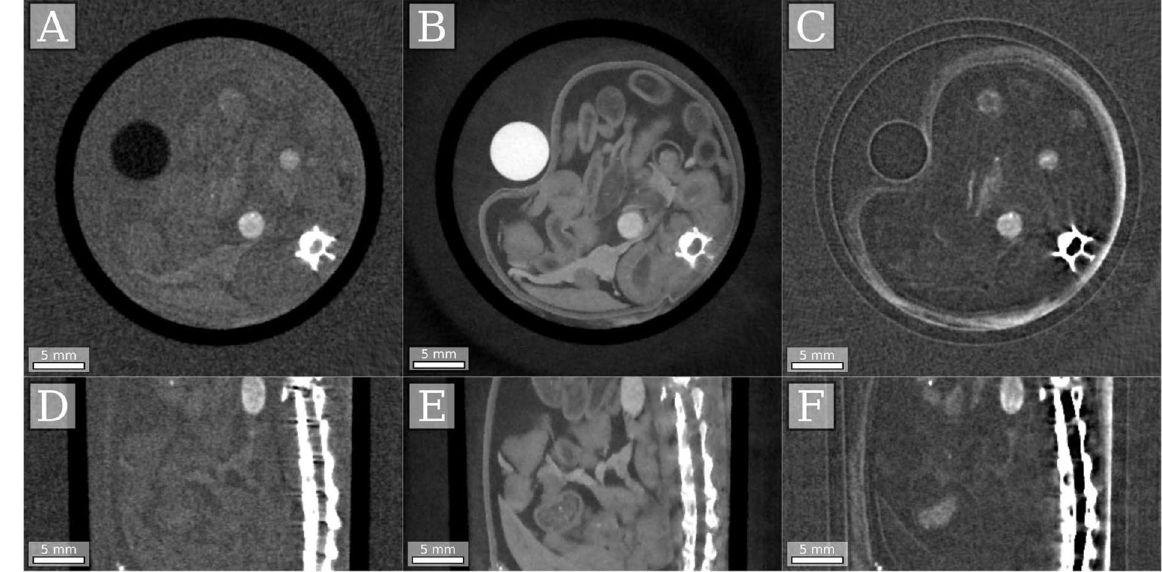
Figure 2. Axial ( A – C ) and sagittal ( D – F ) slices of the reconstructed attenuation coefficient ( A , D ), refractive index decrement ( B , E ) and linear diffusion coefficient ( C , F ) of in-vitro mouse intestines scanned using the described single-shot electromagnetic phase-stepping equivalent acquisition and the direct interferogram-based reconstruction algorithm.